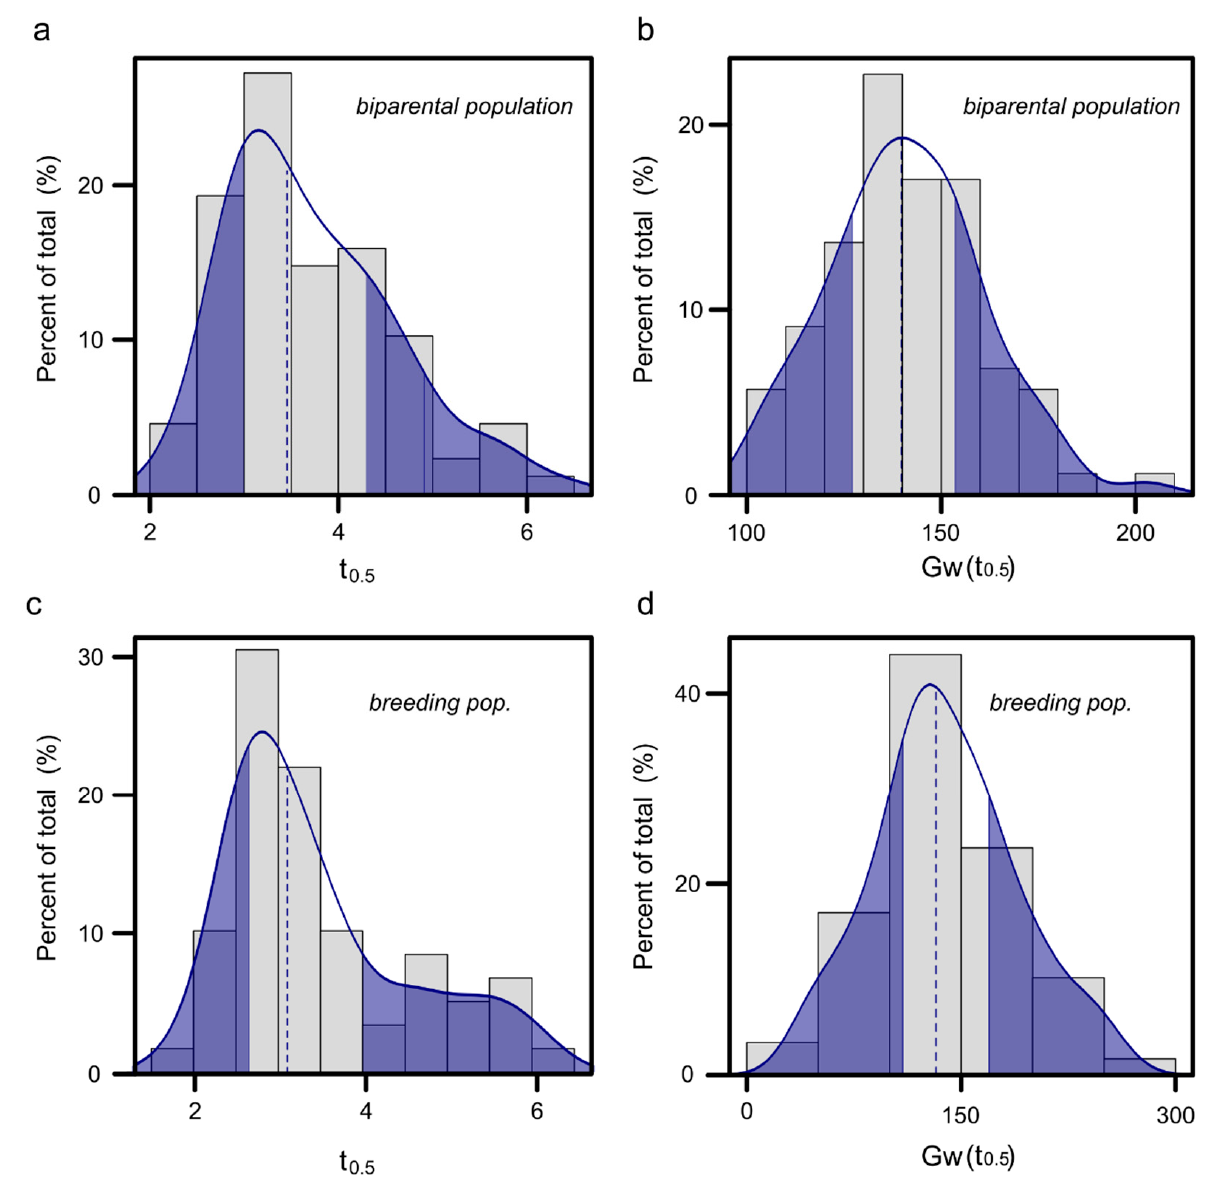
Figure 5. Graphic distribution of t 0.5 and G w ( t 0.5 ) values obtained from two soybean populations. t 0.5 is expressed in days and G w ( t 0.5 ) in mmol H 2 O m 2 s − 1 . A frequency analysis was performed in 177 and 89 genotypes of a biparental and breeding population, respectively. The darker regions repre- sents the 25% of the genotypes with superior and inferior t 0.5 and G w ( t 0.5 ) values of the populations. ( a , b ) biparental population; ( c , d ) breeding population.